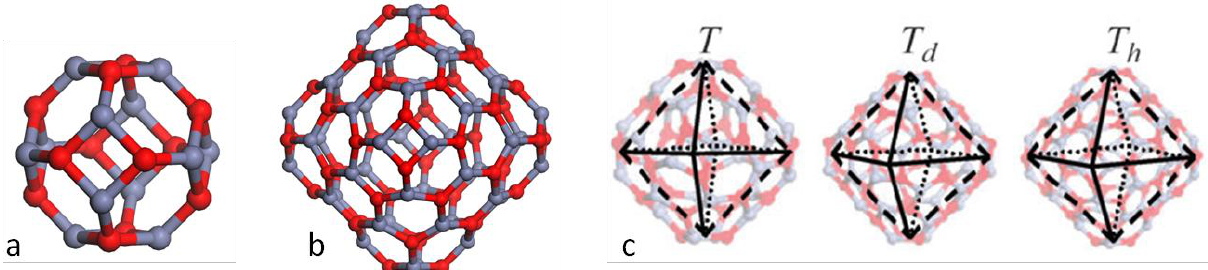
bubbles with: ( a ) n = 12 with symmetry T n ; ( c ) n = 28, 36 and 48 with octahedra h